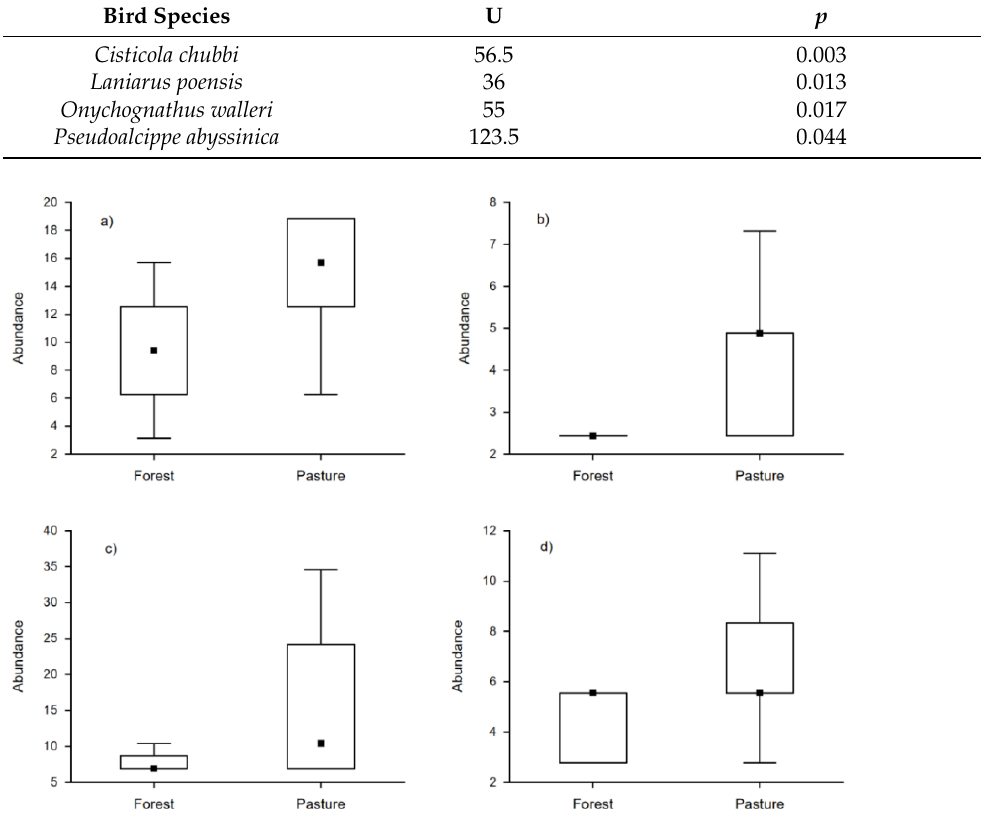
Figure 4. Differences in abundances between forest and pasture for species with increased abun- in pastures: ( a ) Chubb’s cisticola; ( b ) Mountain sooty boubou; ( c ) Waller’s starling; ( d ) African dances in pastures: ( a ) Chubb’s cisticola ; ( b ) Mountain sooty boubou; ( c ) Waller’s starling ; ( d ) Afri- can hill babbler. Points — medians, rectangles — 25 – 75% of data, whiskers — non-outlier range.